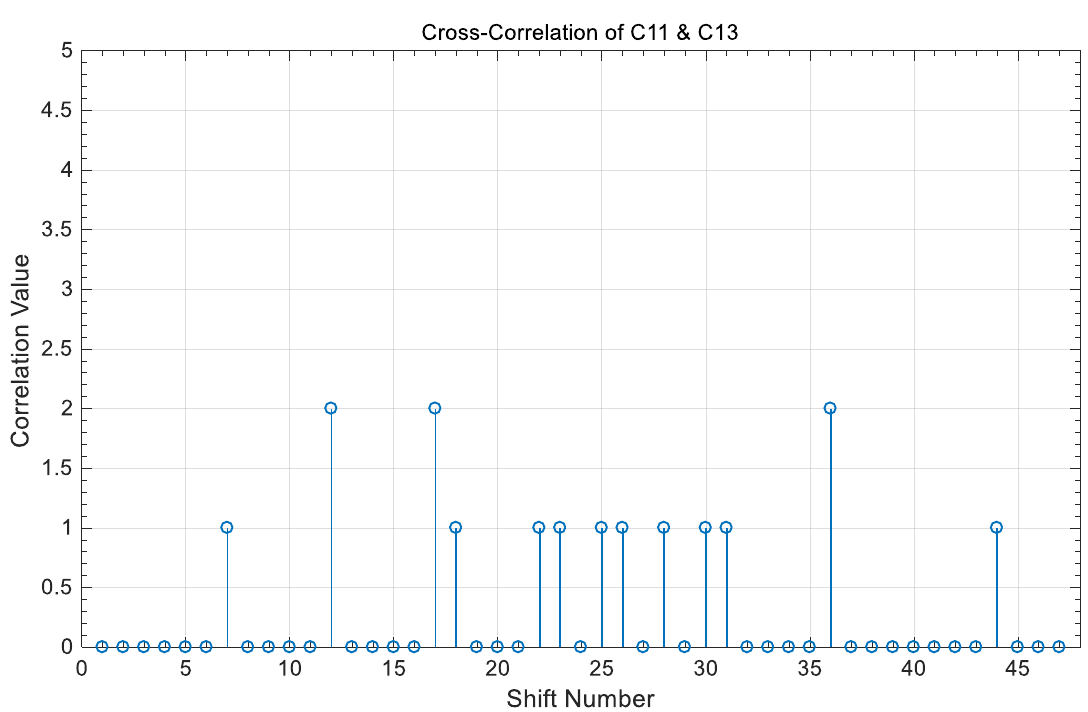
Figure 8. Cross-correlation between 𝐶 11 and 𝐶 13 sequences in same group, 𝑃 1 = 5 and 𝑃 2 = 7.